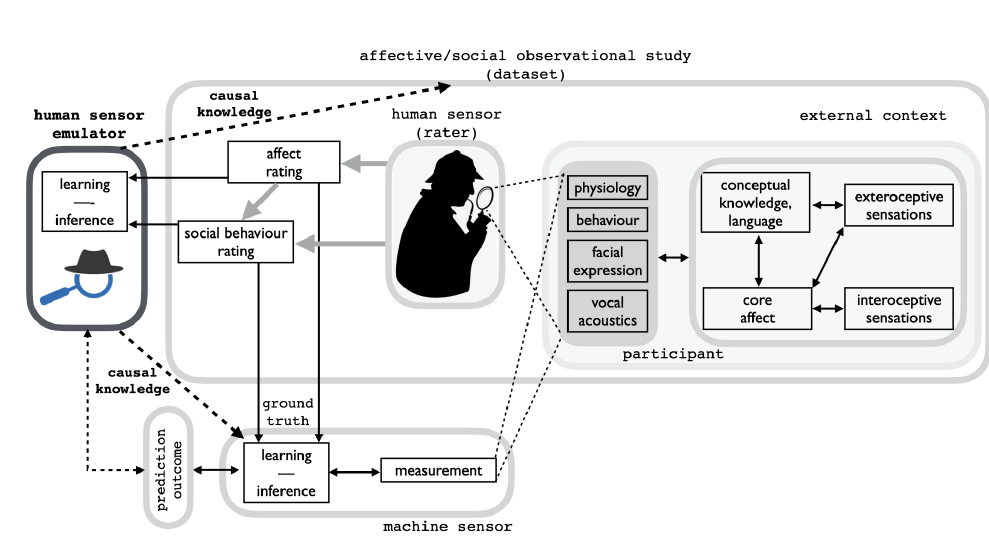
Figure 2. Rater’s emulation in context. The scheme draws on the scenario presented in Figure 1 while highlighting some intricacies. The participant’s behaviour (affective, social) is summarised through a variety of measurements concerning either perceivable cues (e.g., audio, video) and the accompanying physiological responses (e.g., galvanic skin response). On the one hand, the appropriate use of such measurements depends on the measurement model, which in turn entails making specific assumptions on how a participant’s affective and social behaviour are generated [17,18]; here, a psychological constructionist model is assumed (see Section 2). On the other hand, the human sensor is not a passive one, but he/she actively scrutinises participants by relying upon prior conceptual knowledge, language and biases to organize the sensory input. Subsequent ratings, e.g., of affect and social behaviour, can bring about causal dependencies (light gray arrow) between rating stages. The emulation of the rater provides a statistical approximation to the rating process suitable to unveil causal factors impinging on the labelling. The emulator’s results might be exploited to provide complementary information (dashed arrows) either to the corpus itself or to subsequent analyses performed via machine learning